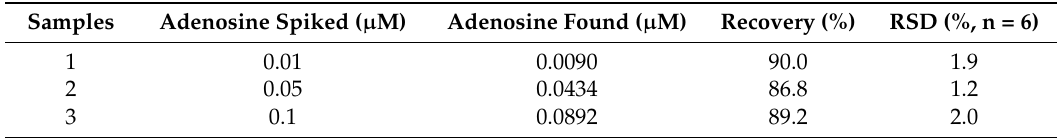
Figure 7. ( A ) The linear relationship between the change of fluorescence intensity and the concentration of adenosine in the urine. ( B ) shows the fluorescence spectra of ABA+TPE in urine diluted with Tris-HCL buffer after put in 0, 0.005, 0.01, 0.03, 0.05, 0.075, 0.1, and 0.12 µ M of adenosine with an excitation wavelength of 470 nm. Table 1. Determination of adenosine in urine samples using the proposed probe.